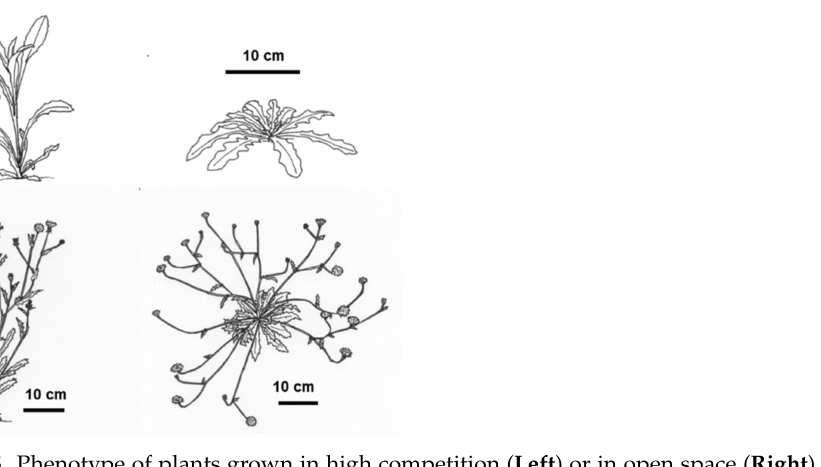
Figure 5. Phenotype of plants grown in high competition ( Left ) or in open space ( Right ), both in juvenile ( Top ) and mature ( Bottom ) stages.